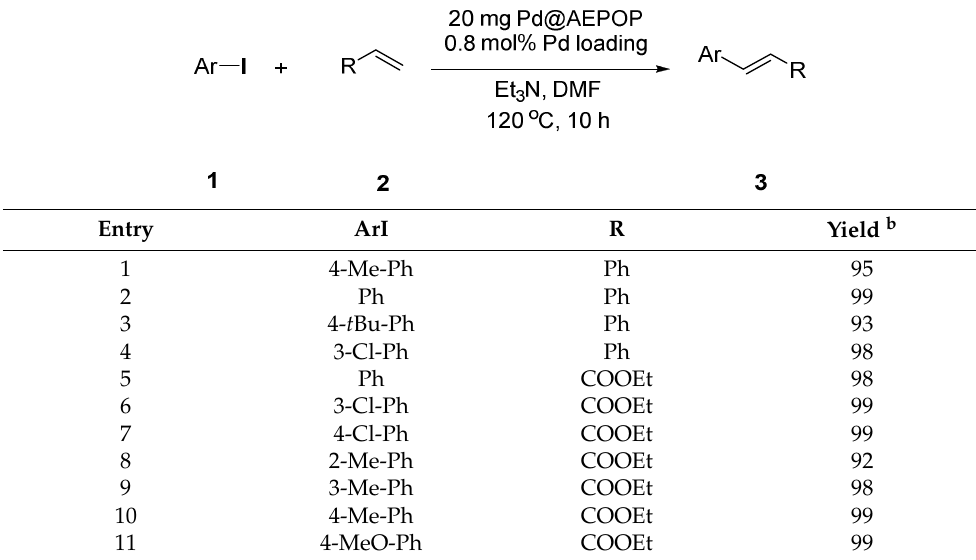
Table 2. Substrate scopes of Heck reactions a .